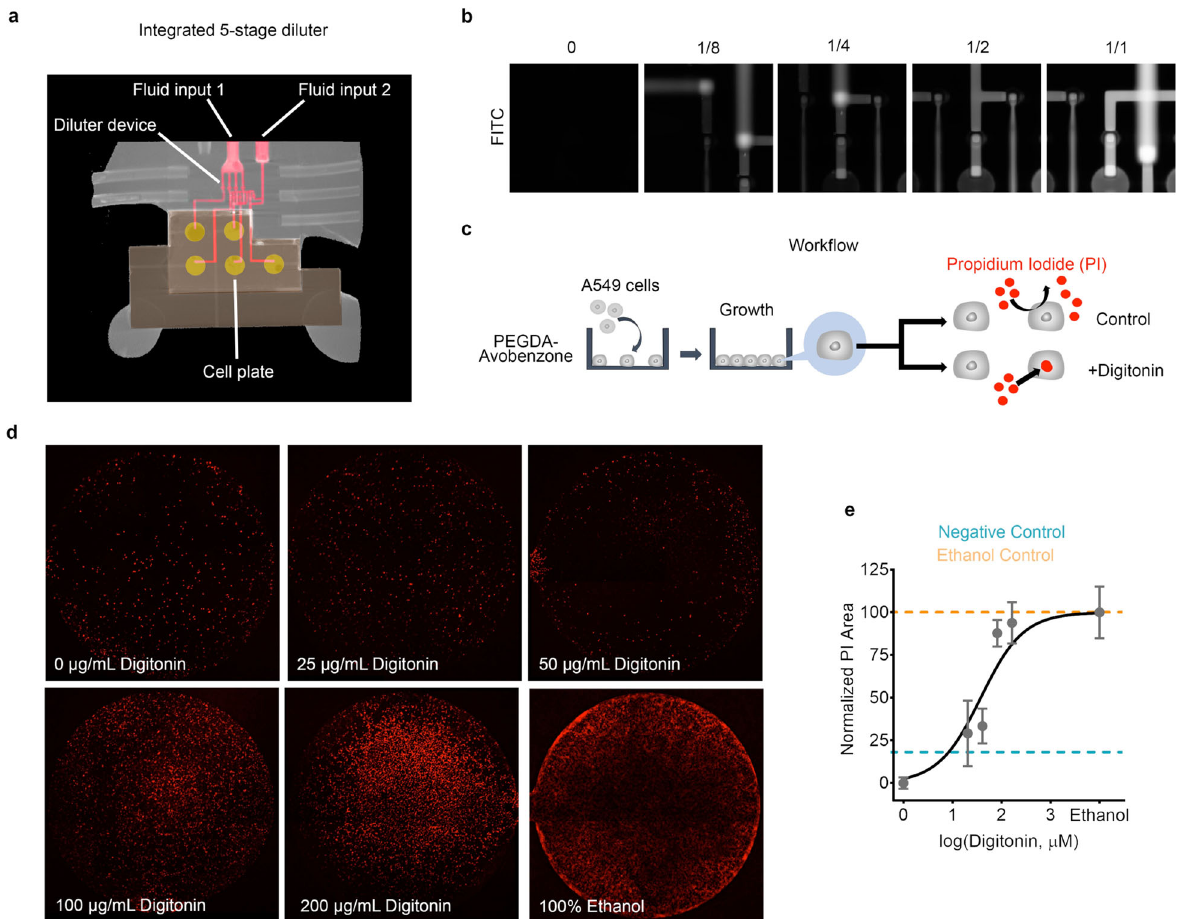
Fig. 7 Digitonin permeabilization assay. a μ CT image of 3D printed 5-stage diluter integrated with 3D printed cell plate. b Fluorescence images of serially diluted fl uorescein. The experiment was repeated three times and all show similar results. c Cell treatment work fl ow. d Whole well images of differentially treated A549 cells with propidium iodide as a marker (red). The treatment fl uid was 100 μ g/mL digitonin and 2 μ M propidium iodide in DMEM/F12 while the control fl uid was 2 μ M propidium iodide in DMEM/F12. 100% ethanol was used as a positive control for the whole experiment. e The semi-log dose response-curve was derived from the experiment. Responses were quanti fi ed through the measurement of propidium iodide area relative to the total cell area (DIC). Bounds were set at 0 μ g/mL digitonin (0 response) and 100% ethanol (100% response). Values were derived from n = 3 independent experiments. Error bars denote standard